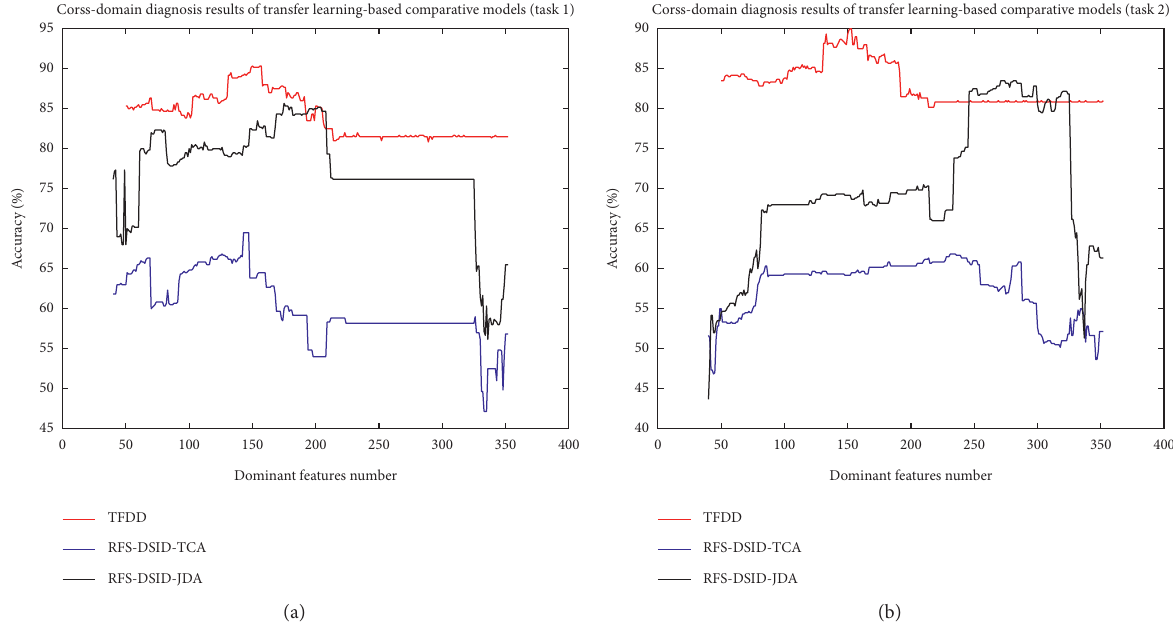
Figure 18: The diagram of cross-domain fault diagnosis results of transfer learning-based comparative models. Comparison of motor fault diagnosis results